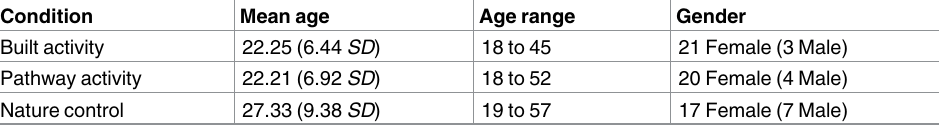
Table 16. Mean age, age range and gender of the three